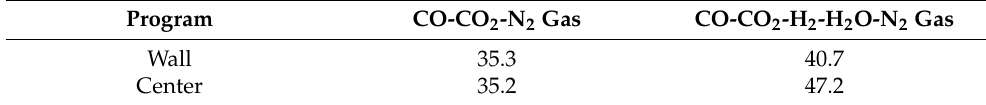
Figure 12. Reduction curves against ( a ) the experimental time in a CO-CO 2 -N 2 gas, ( b ) the sample temperature in a CO-CO 2 -N 2 gas, ( c ) the experimental time in a CO-CO 2 -H 2 -H 2 O-N 2 gas, and ( d ) the sample temperature in a CO-CO 2 -H 2 -H 2 O-N 2 gas, for non-isothermal reductions, simulating the BF wall and center conditions. Table 4. Final reduction degrees for the pellets in the non-isothermal